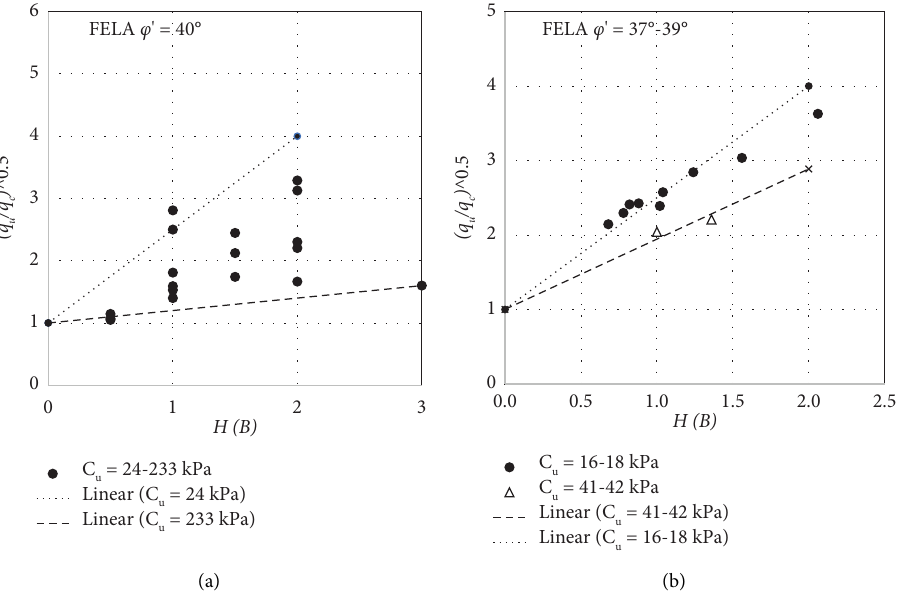
Figure 7: ( q q ) 0 . 5 versus H/B for unstabilised granular layer (data source: Kumar and Chakraborty [36]): (a) FELA ϕ ′ � 40 ° and (b) FELA u / c ϕ ′ � 37 ° –39 °